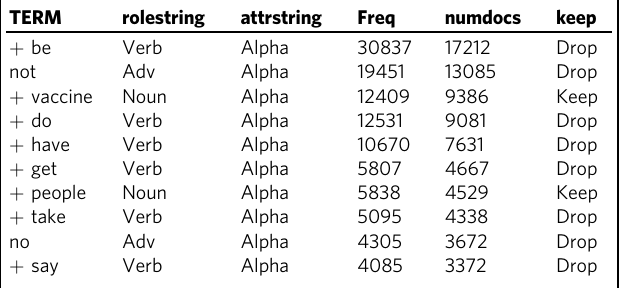
Table 1 Excerpts of the text parsing results.